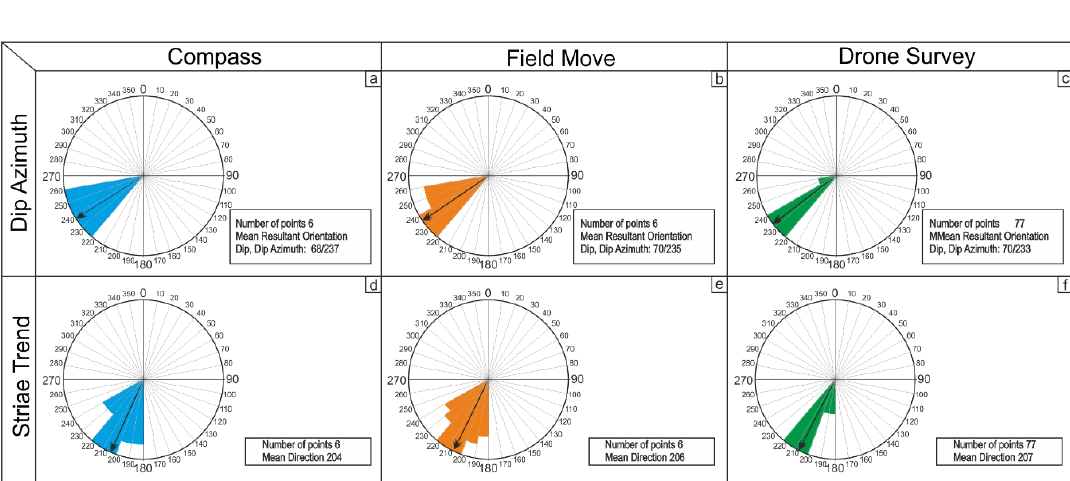
Figure 9. Comparison between the fault attitude and striations trends measured through high-resolution sampling on the CAB using traditional compass-clinometer ( a , d ), Fieldmove App on a digital device ( b , e ), and virtual outcrop reconstructed from drone-acquired imagery ( c , f ). The upper plots ( a – c ) shows the fault dip-azimuth; the lower plots ( d – f ) shows the trend of associated striae; for each rose diagram, the mean value resulting from the statistical analysis of the dataset is reported in the bottom-right rectangle Rose diagrams were extracted through Move 2019 software and redrawn through Corel Draw X4 software.